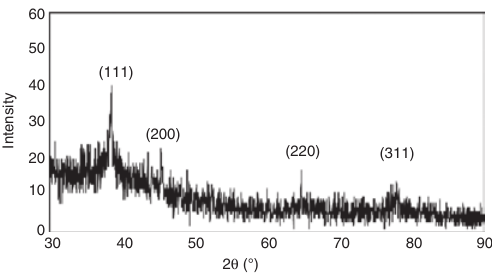
Figure 7: X-ray diffraction pattern of the synthesized AuNPs using mushroom extract at obtained optimum